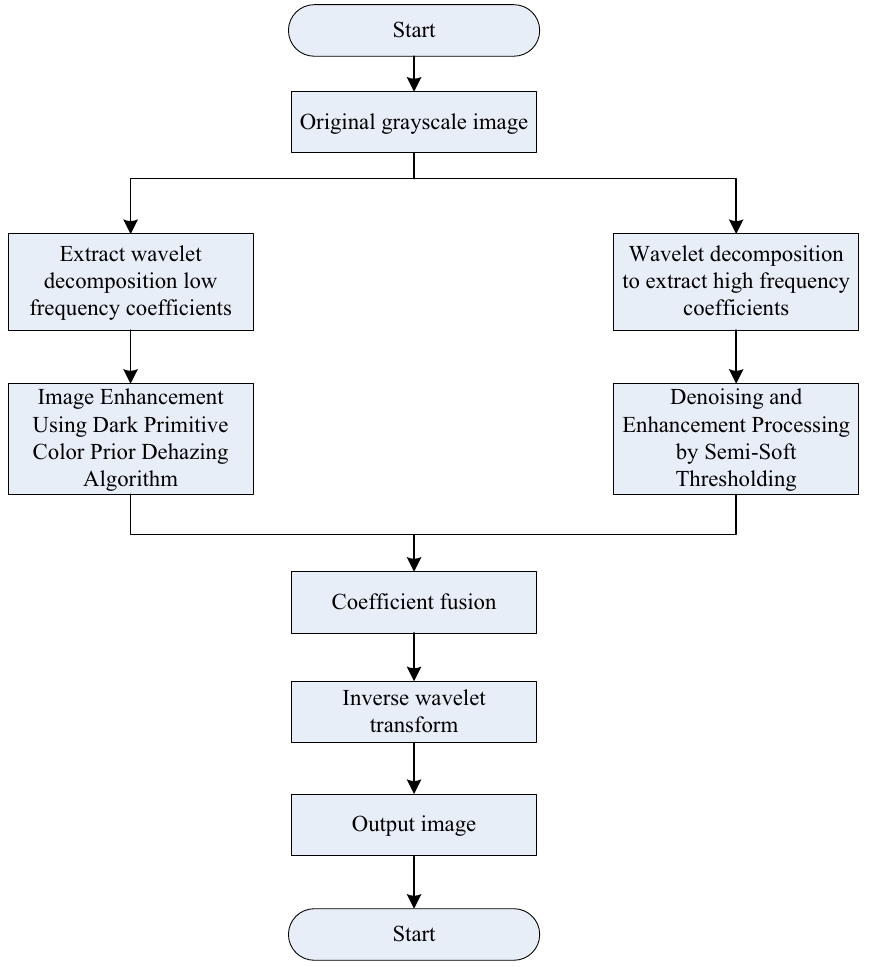
Figure 7. The flowchart of the improved wavelet transform image enhancement